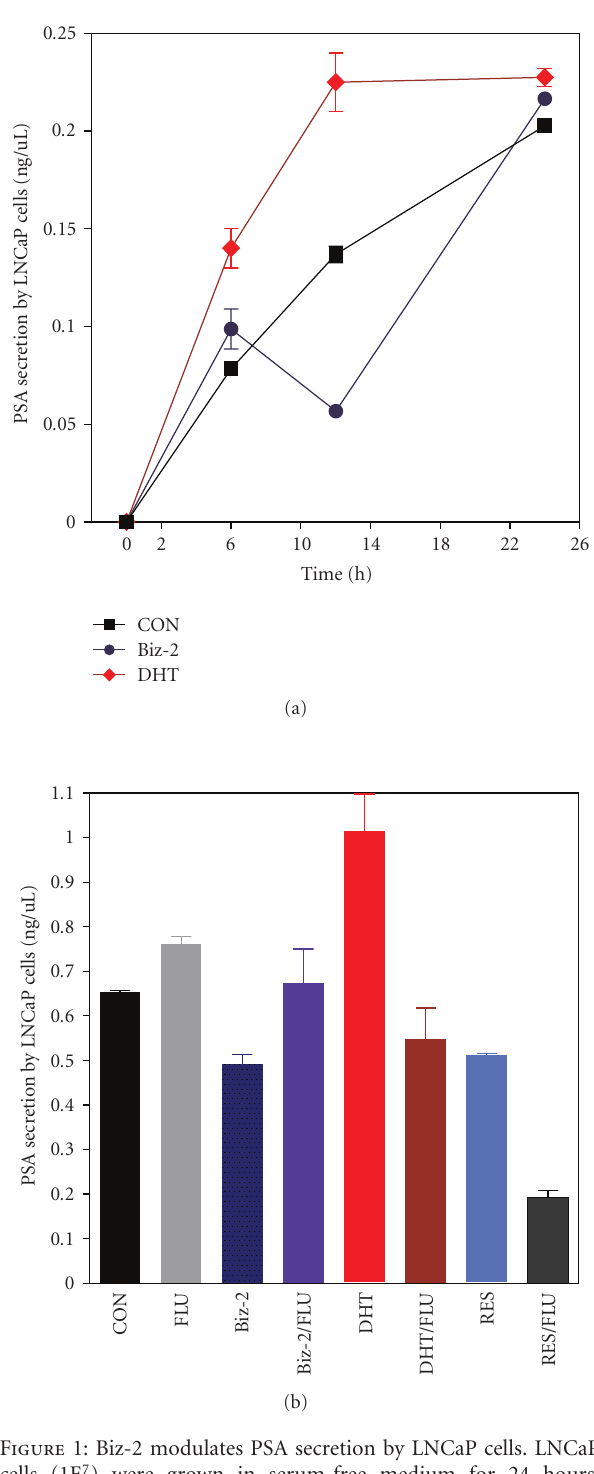
Figure 1: Biz-2 modulates PSA secretion by LNCaP cells. LNCaP cells (1E 7 ) were grown in serum-free medium for 24 hours, then induced with 100ppm of Biz-2 for 0, 6, 12, and 24 hours. Equal aliquots (10uL) of the condition medium were removed and analyzed by PSA ELISA (see Section 2). (a) Time-dependent secretion of PSA. (b) PSA secretion induced with 10ppm Biz- 2 for 24 hours in the presence and absence of 10 nM flutamide. The values are the mean ± SEM of three separate experiments performed in triplicate. CON: control; DHT: dihydrotestosterone; Biz-2: ether extract of Bizzy nut; RES: